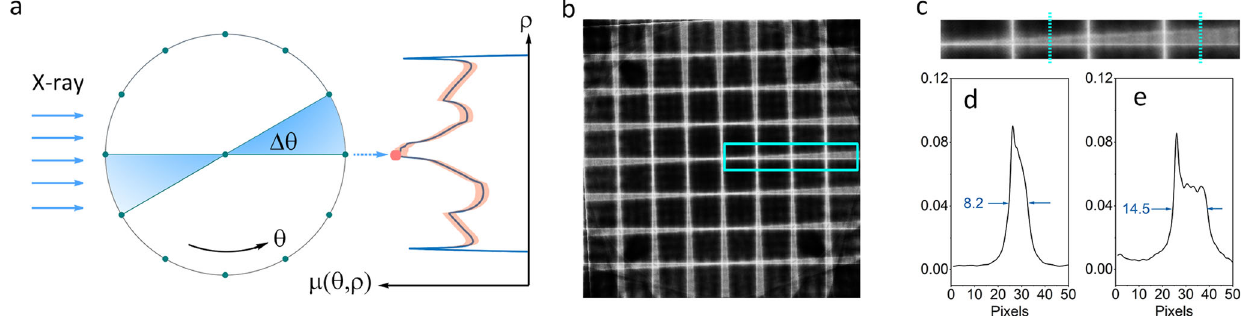
Fig. 1 Blurring effects in fl y-scan. a Schematics of a fl y-scan data collection. The blue shadow illustrates the area that is exposed to x-ray under single exposure. In the line pro fi le, the red part manifests the blurring effects compared to the blur curve obtained in the regular step-scan, as indicated by Eq. (4). b Simulated reconstruction of a grid pattern with blurring angle Δθ = 1·5 degrees. The image size is 512 × 512 pixels. The width of horizontal and vertical is 1 pixel. c Enlarged view of area enclosed by the blur rectangular in ( b ). d , e Line pro fi les at two positions indicated by the dashed lines in ( c